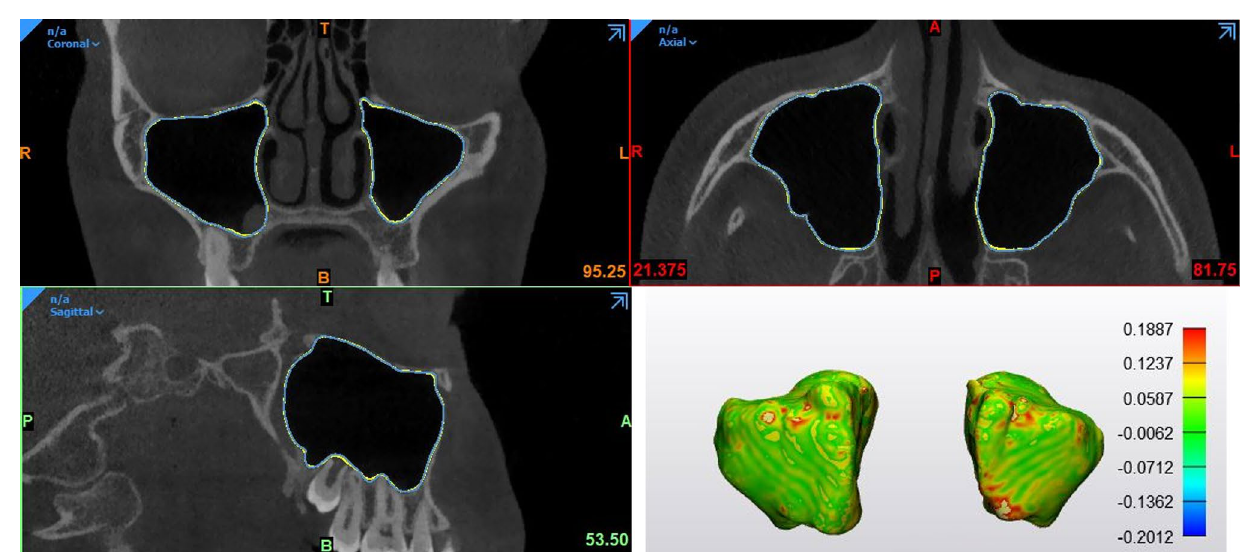
Figure 4. Overlap between automatic segmentation (yellow color) and ground truth (blue color) in 3 orthogonal planes, RMS in mm between STL surfaces illustrated with a color